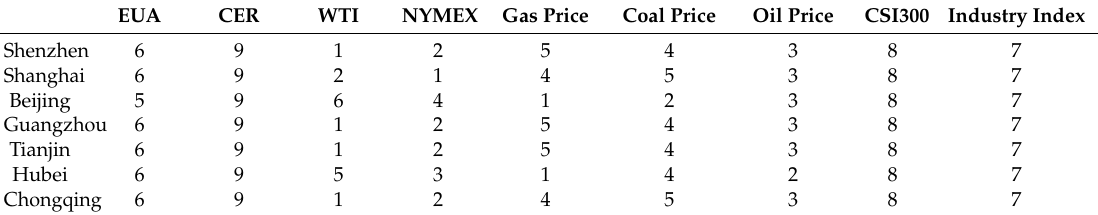
Table 9. Rank of the selected influence factors in Deng’s grey relational model.